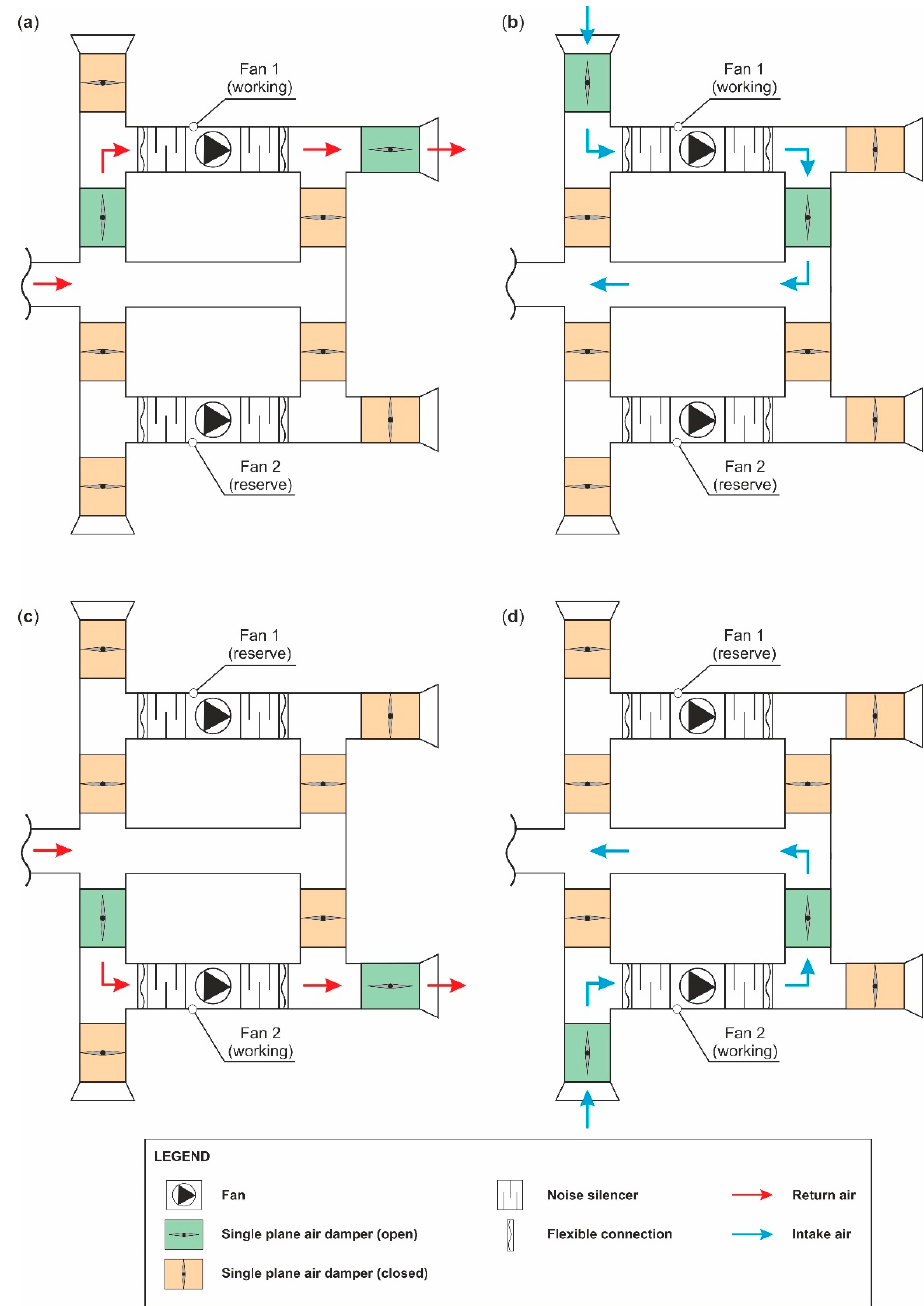
Figure 9. Damper positions during normal and reversed fan operation (solution no. 1): ( a ) fan 1 working—normal ventilation; ( b ) fan 1 working—reverse ventilation; ( c ) fan 2 working—normal ventilation, ( d ) fan 2 working—reverse ventilation.